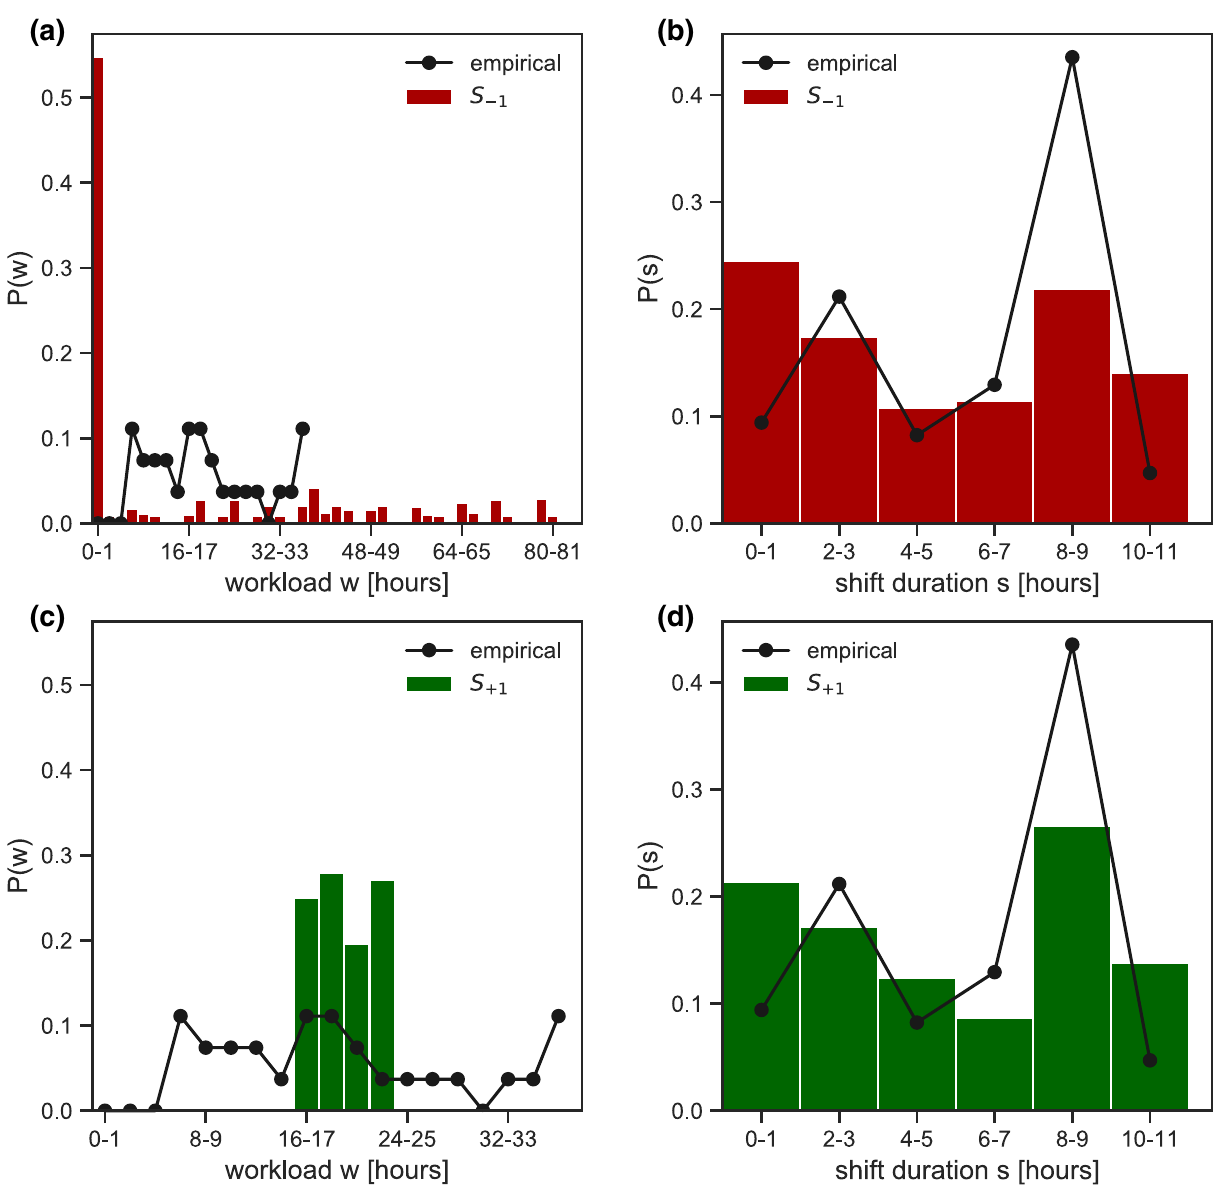
Figure 4. Workload and shift duration in the reorganized schedule under constraints on shift. ( a , b ) Probability distribution of nurses’ workload w ( a ) and shift duration s ( b ) following the reorganization of shifts, compared to the empirical distributions. The reorganization is based on model S − 1 (i.e. constraint on shift duration and attractive potential). ( c , d ) As panels ( b ) and ( c ) for model S + 1 (constraint on shift duration with repulsive